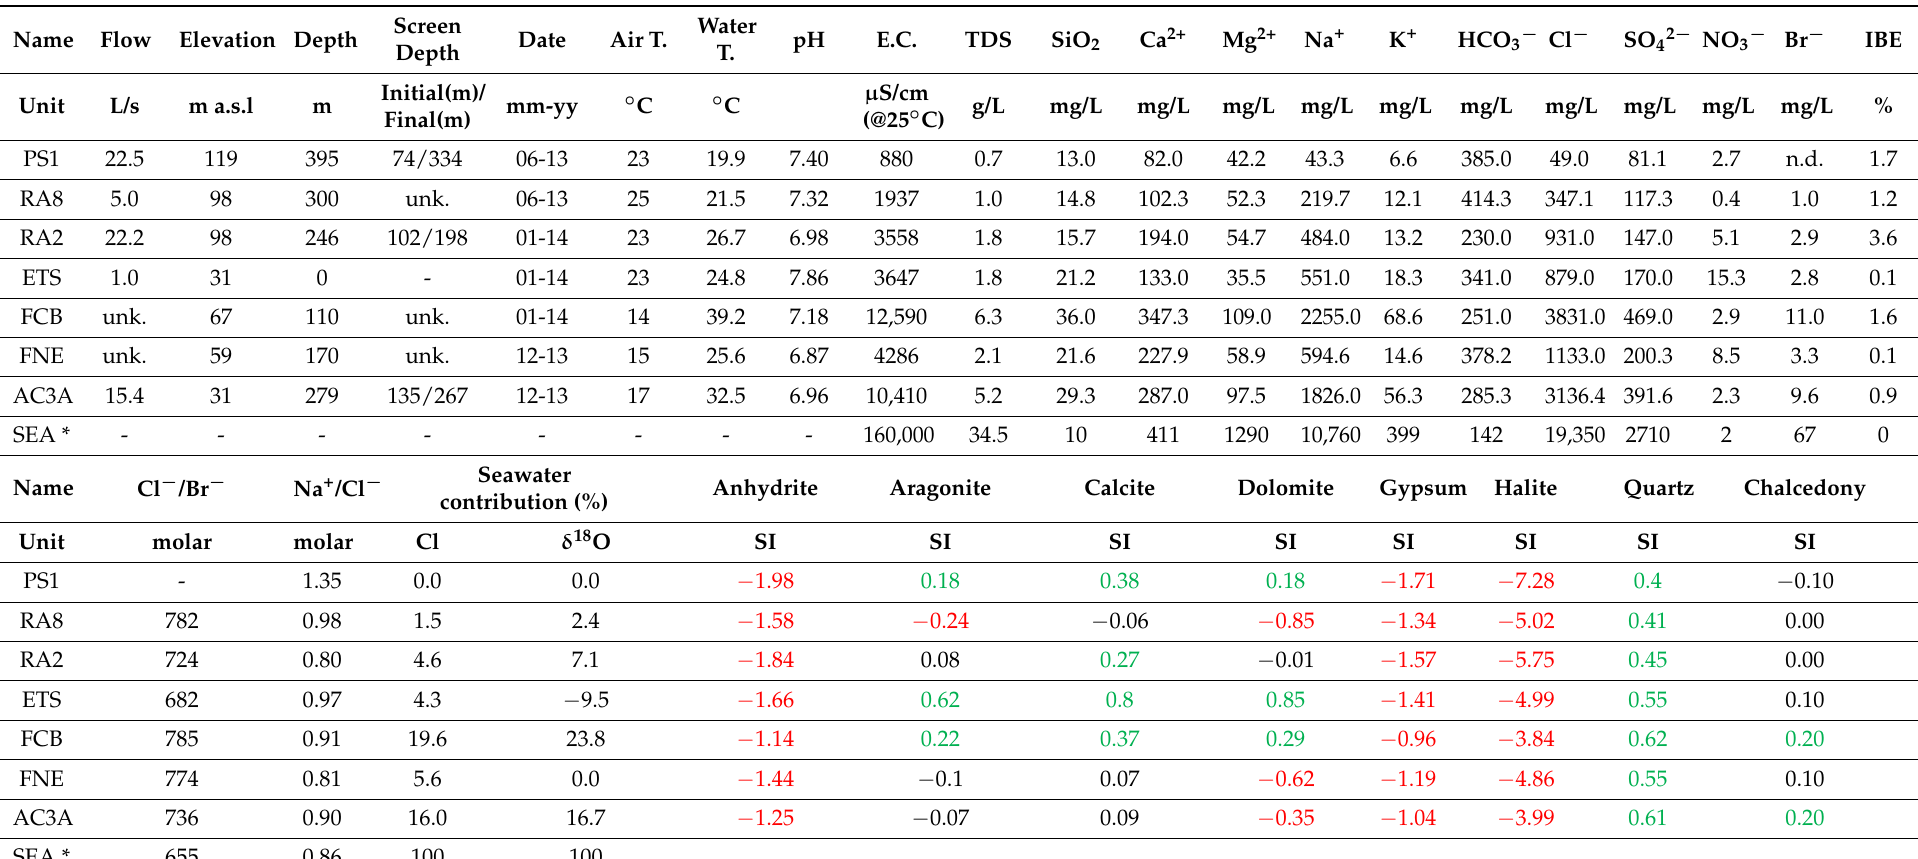
Table 1. Construction and operating characteristics of the sampling points and chemical composition of sampled waters. TDS—Total Dissolved Solids; IBE—Ionic Balance Error; n.d.—not determined; unk.—unknown; Calculations of Chloride-Bromide and Sodium-Chloride (molar) ratios, Seawater contribution and Solubility Index (SI) for the minerals that could be present in the host rocks, have been also included. Red and green font colors of SI represent subsaturation and oversaturation states arbitrarily assuming SI values lower and higher than − 0.1 and +0.1, respectively. * From